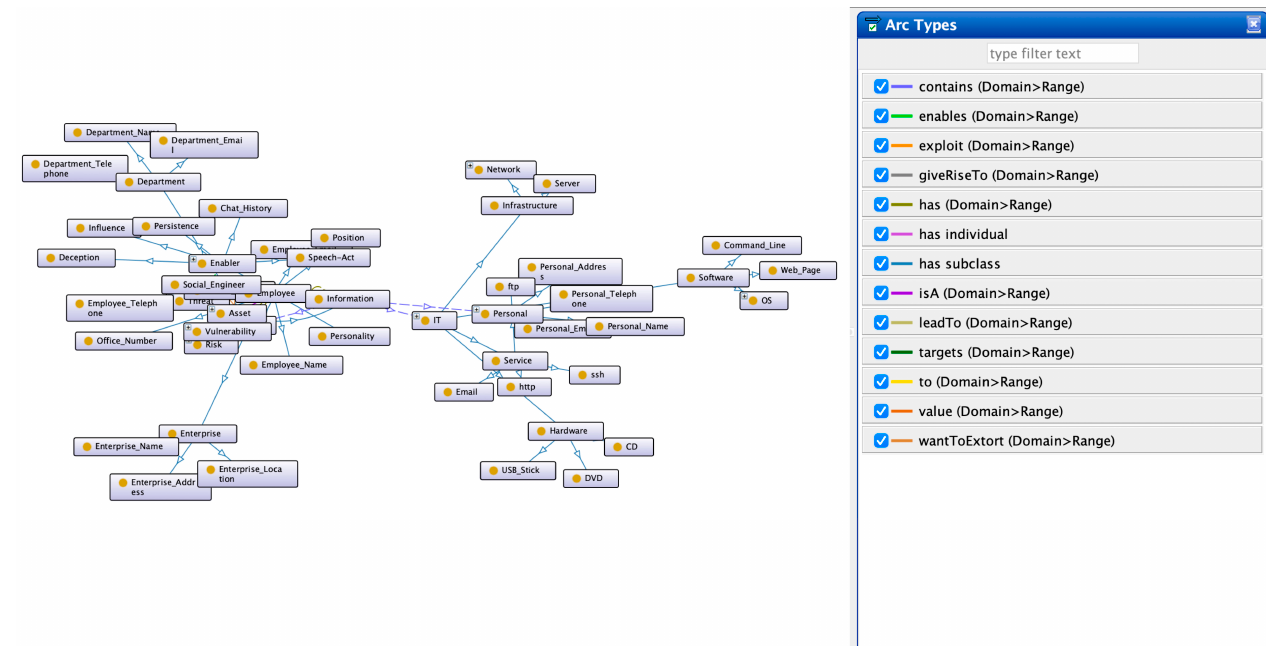
Figure 7. Excerpt of CSE ontology.